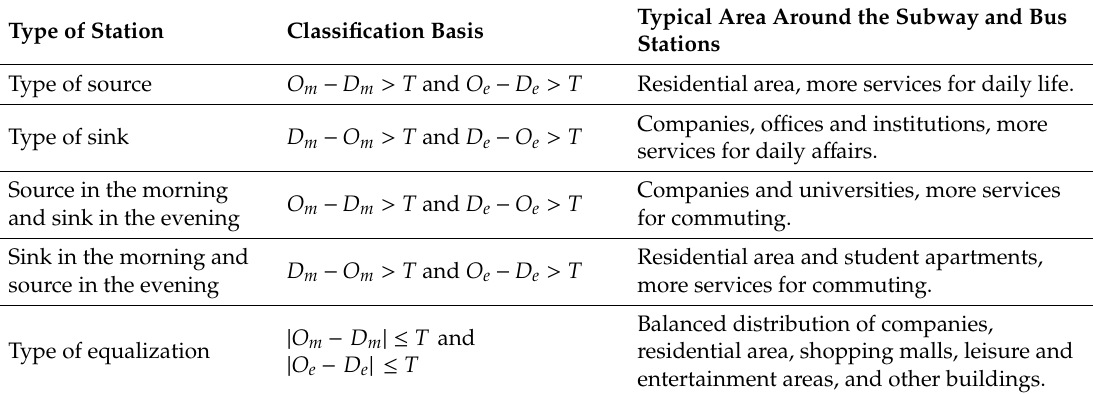
Table 2. Sink-source characteristics of the shared bicycles around the subway and bus